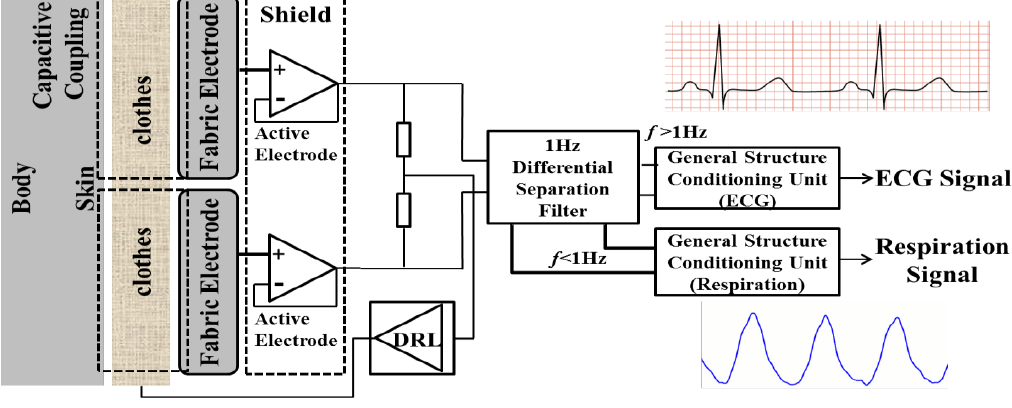
Figure 2. Block diagram of capacitive measurement